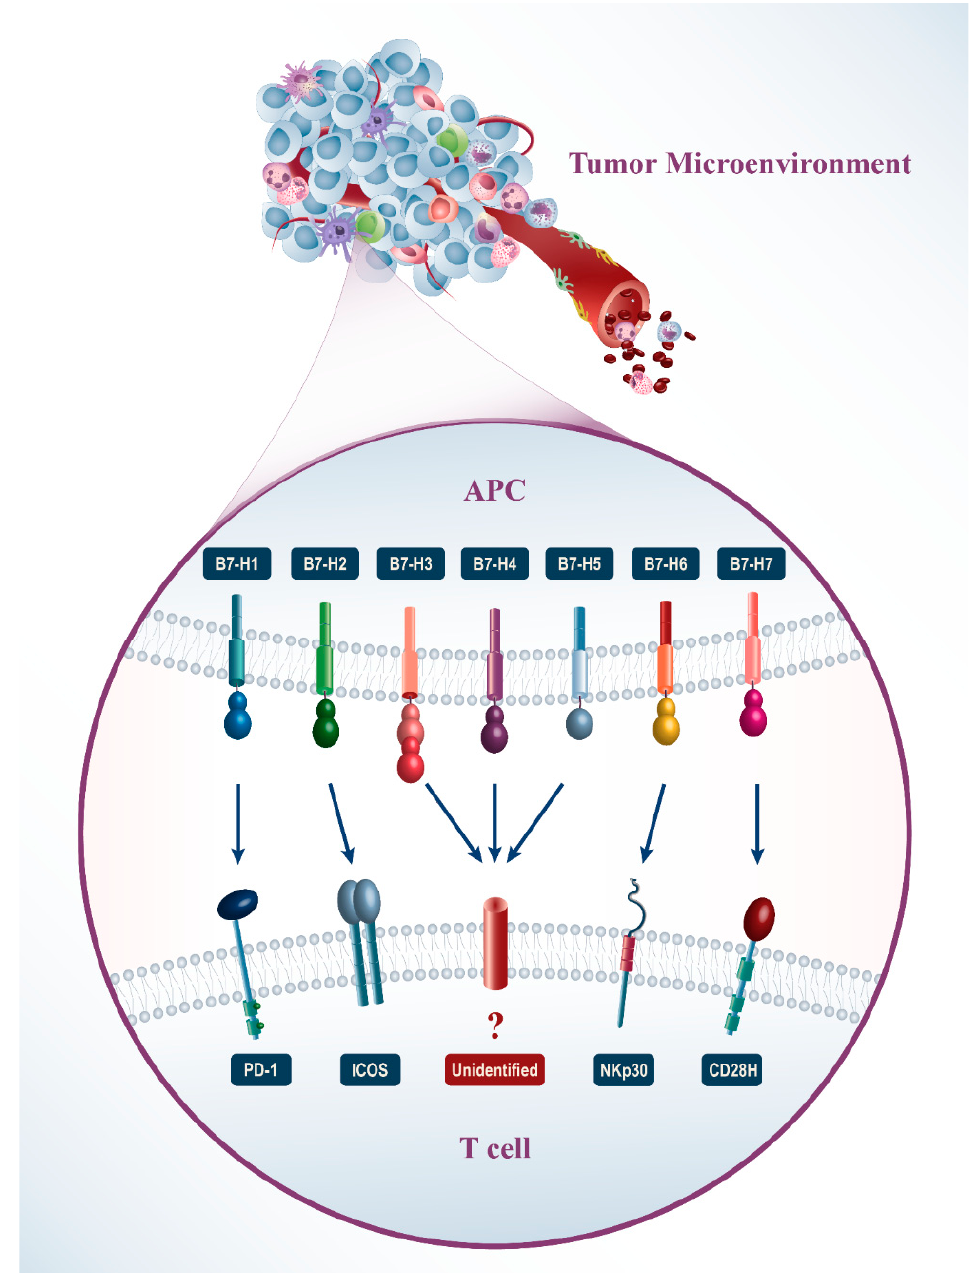
Figure 1. In recent years, immunotherapy has received much attention in cancer therapy and immune checkpoint molecules have a predominant position herein. These molecules are expressed on the surface of several immune cells such as T lymphocytes or other immune cells that are thought to interact with the ligand (e.g., in some cases NK cells, B cells, monocytes) and generate signals to regulate their function. Here, we summarize some features of the B7 family immune checkpoint molecules and highlight whether they are involved in chemoresistance processes and may be considered emerging targets to overcome cancer therapy resistance.